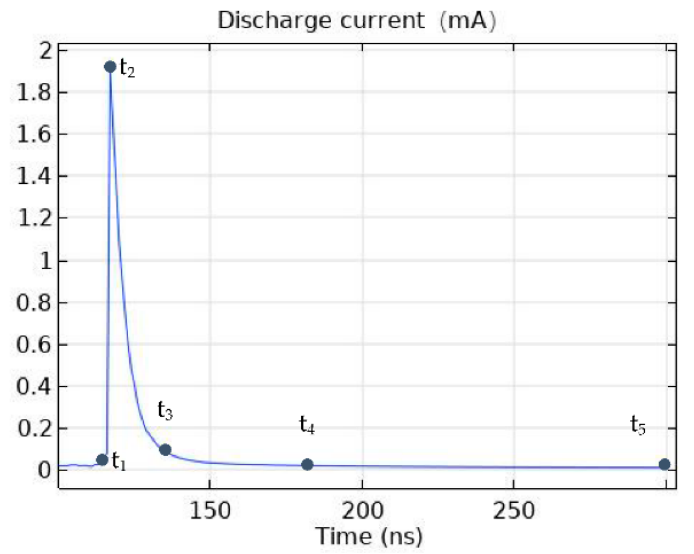
Figure 3. Negative corona discharge current waveform. Figure 4 shows the electric field intensity E, space charge density ρ , electron number density N e , positive ion density N P (N 2+ , N 4+ , O 4+ , O 2+ , and N 2 O 2+ ), and negative ion density N n (O 2 − and O − ) at different times of each